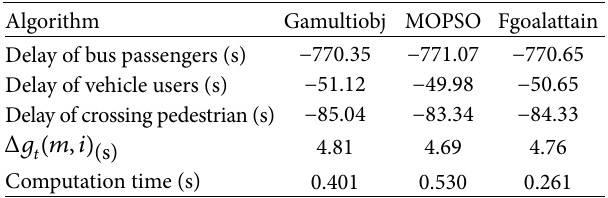
Table 8: Results of delay model in situation 3 during the peak period.